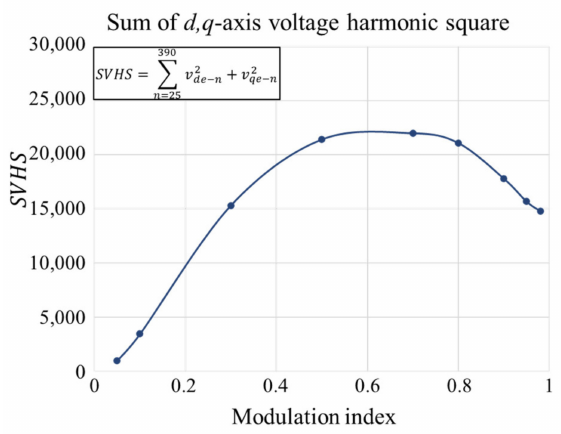
Figure 6. Variation of the sum of the d- and q-axis voltage harmonic square with the modulation index of the 25th–390th harmonics when the switching and fundamental frequencies are 10 kHz and 200 Hz,